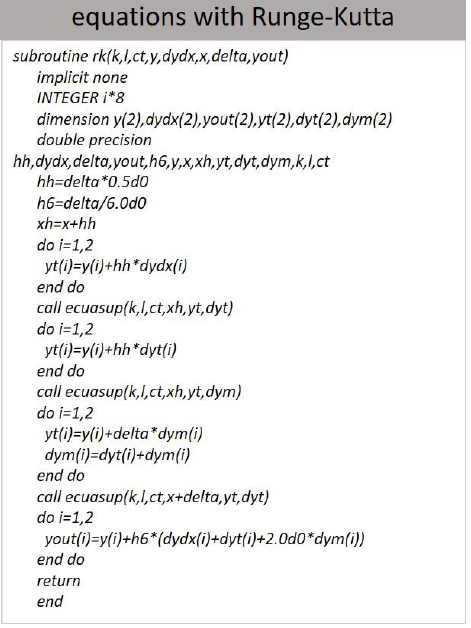
Figure 1. Solution of surface equations with Runge – Kutta .